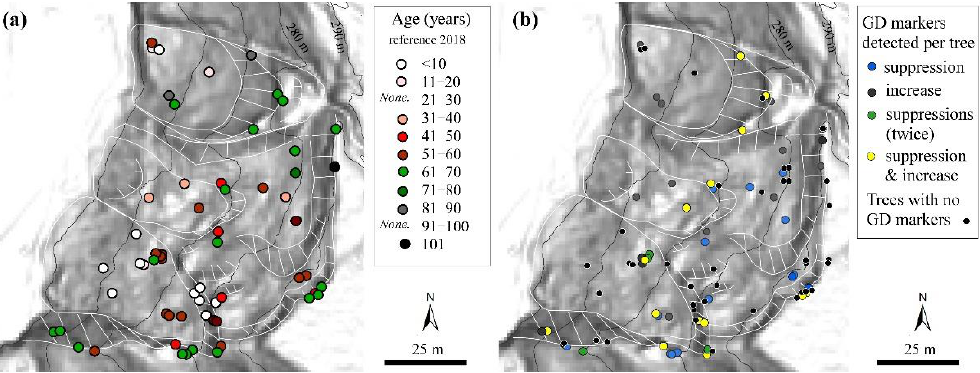
Figure 5. Spatial distribution of tree ages and detected GD markers and trees with no GD markers. ( a ) Spatial distribution of the ages of 60 trees sampled for dendrogeomorphological analysis. ( b ) Spatial distribution of detected GD markers for individual trees.